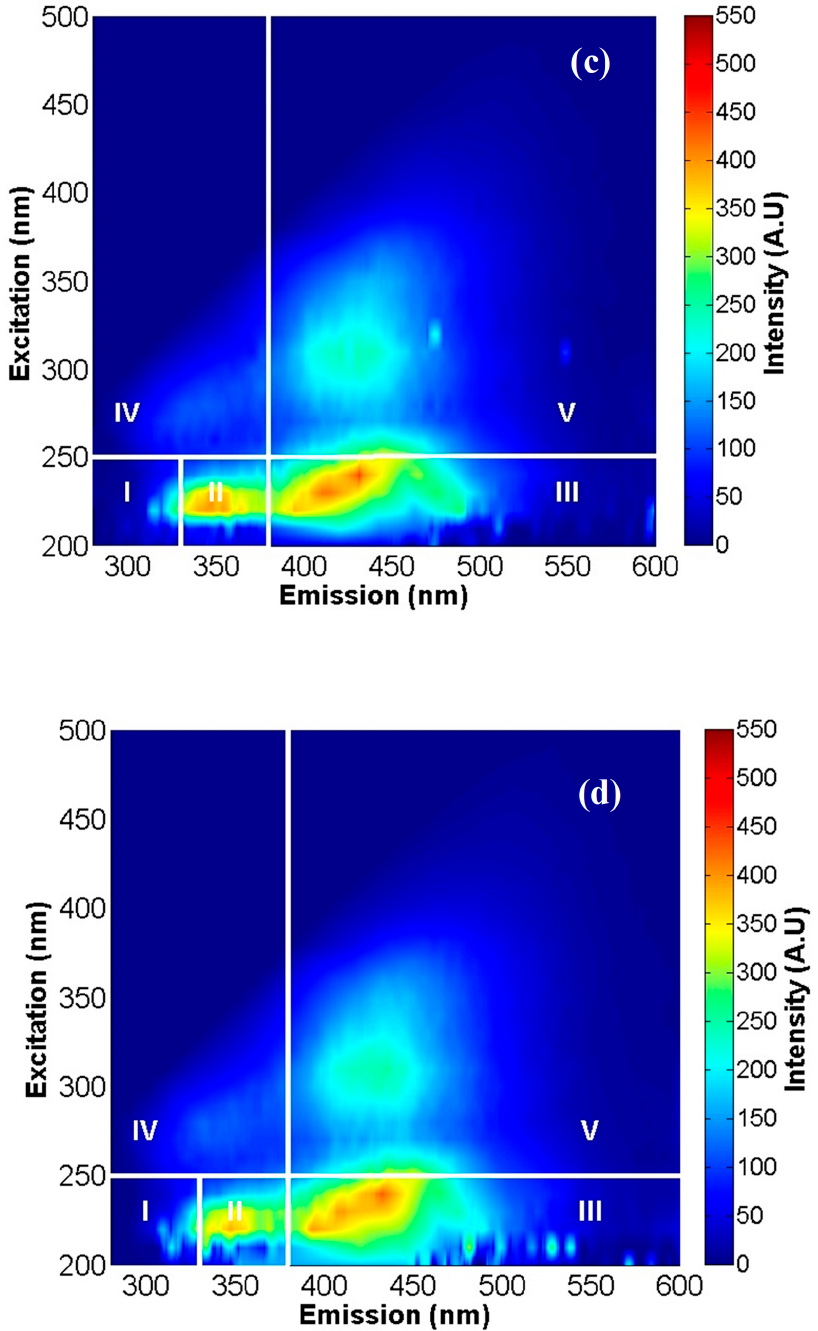
Figure 6. 3D fluorescence excitation–emission matrix (3DEEM) fluorescence spectra for ( a ) feed solution (prefiltered with 0.45 µ m filter); ( b ) permeate 10 kDa; ( c ) permeate 50 kDa, and ( d ) permeate 100 kDa. Region I and II = aromatic protein-like substances I and II, respectively; Region III = fulvic acid-like substances; Region IV = soluble microbial by-products; Region V = humic acid-like